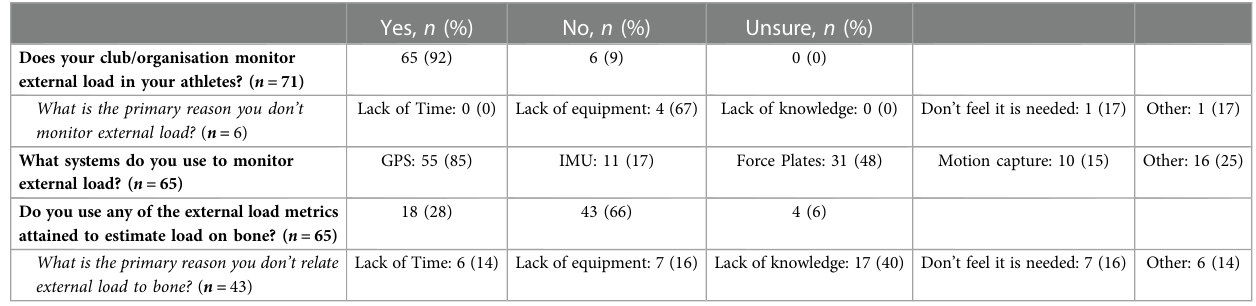
TABLE 1 Support staff response to using external load monitoring in